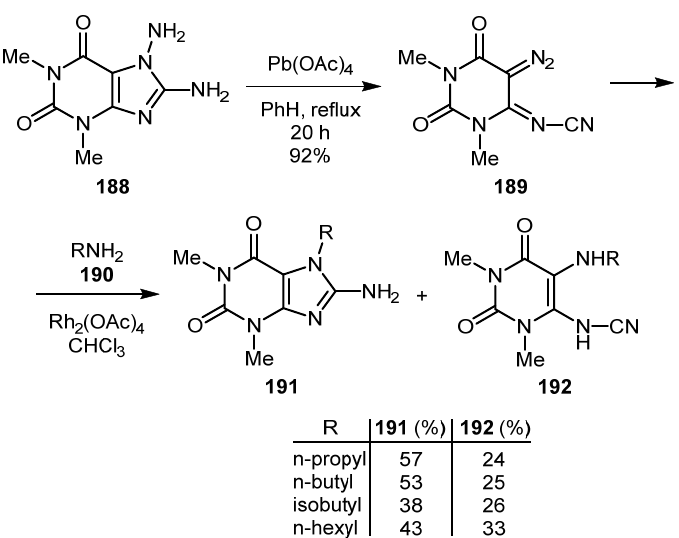
Scheme 46. Synthesis of theophyllines from diazobarbituric acid derivative and